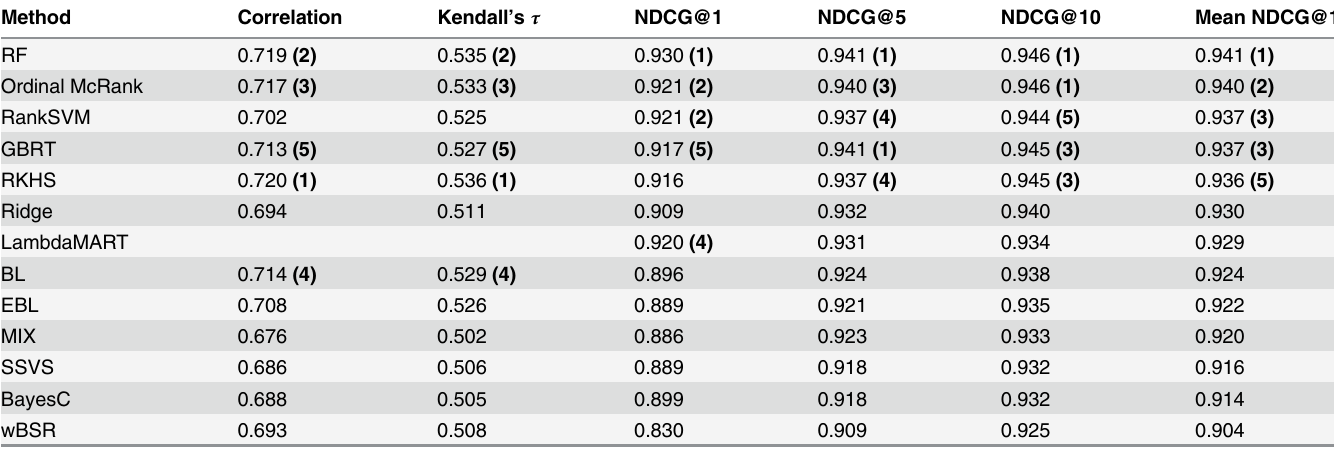
Table 5. Cross-validation results on the Rice dataset, averaged across 14